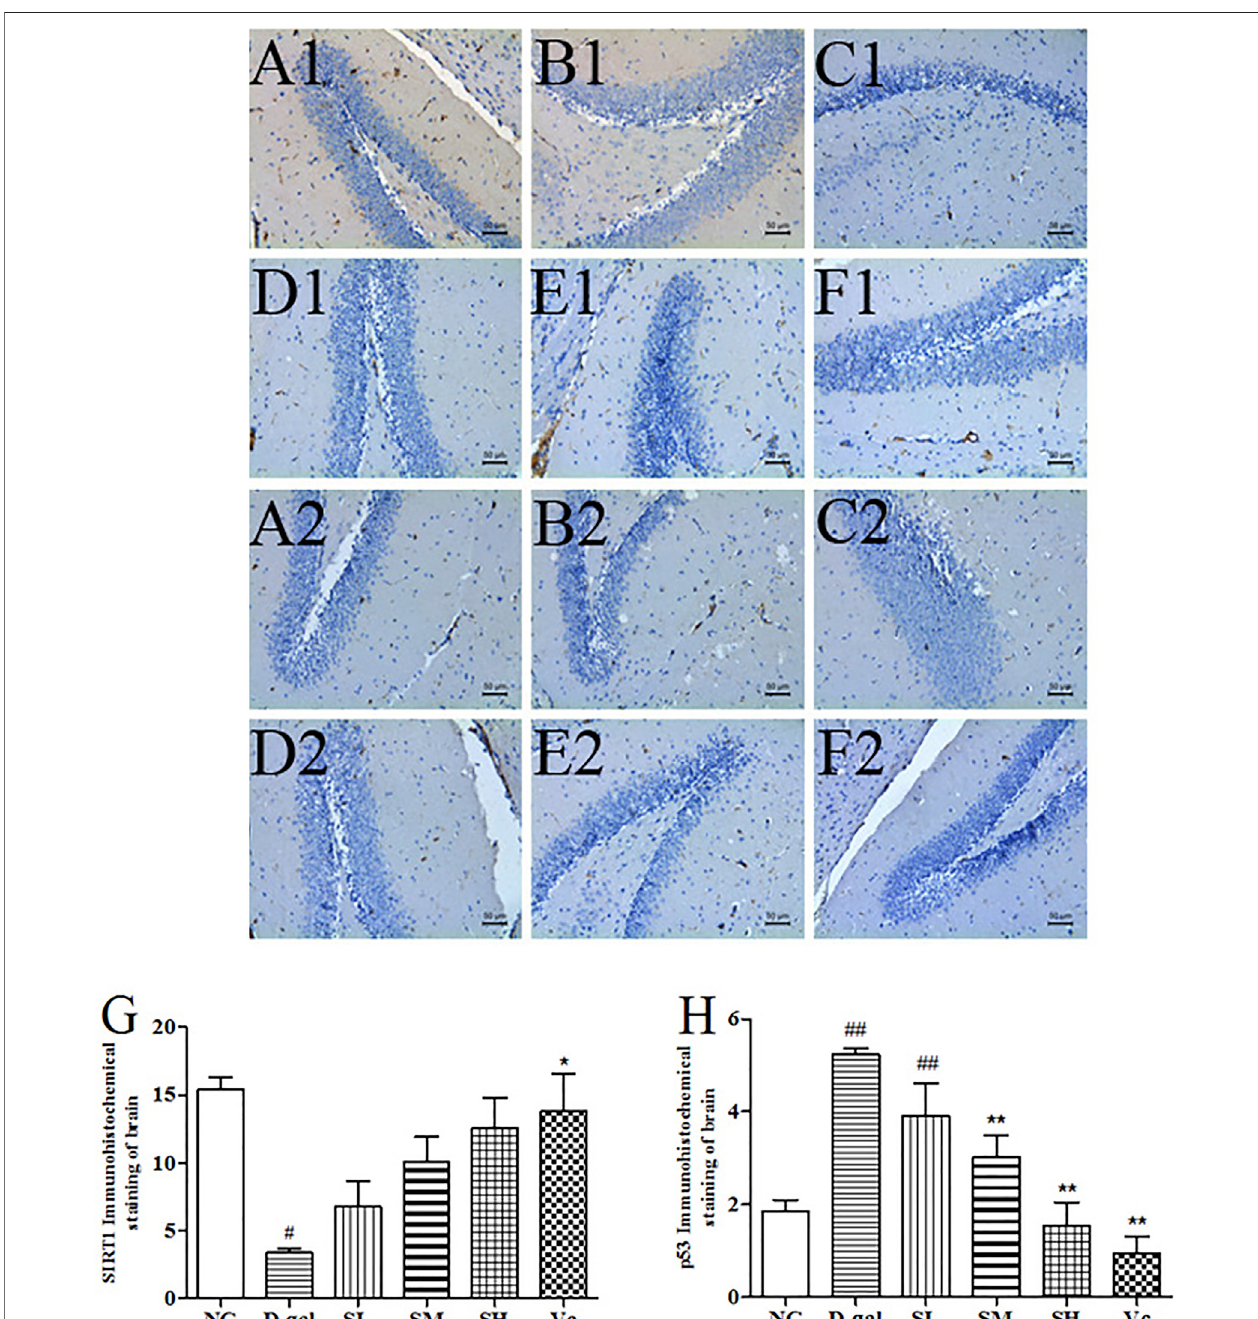
FIGURE8| TheSIRT1andp53proteinsexpressioninthebraintissuesofeachgroup( × 200).SIRT1(A1 – F1),A1:NCgroup,B1:D – galgroup,C1:low –